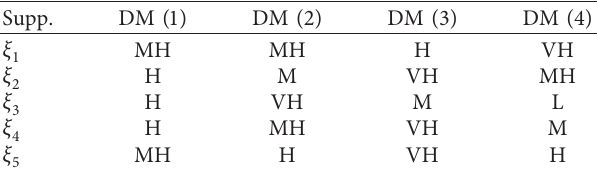
Table 5: The ratings of the alternatives for ϖ Supp.